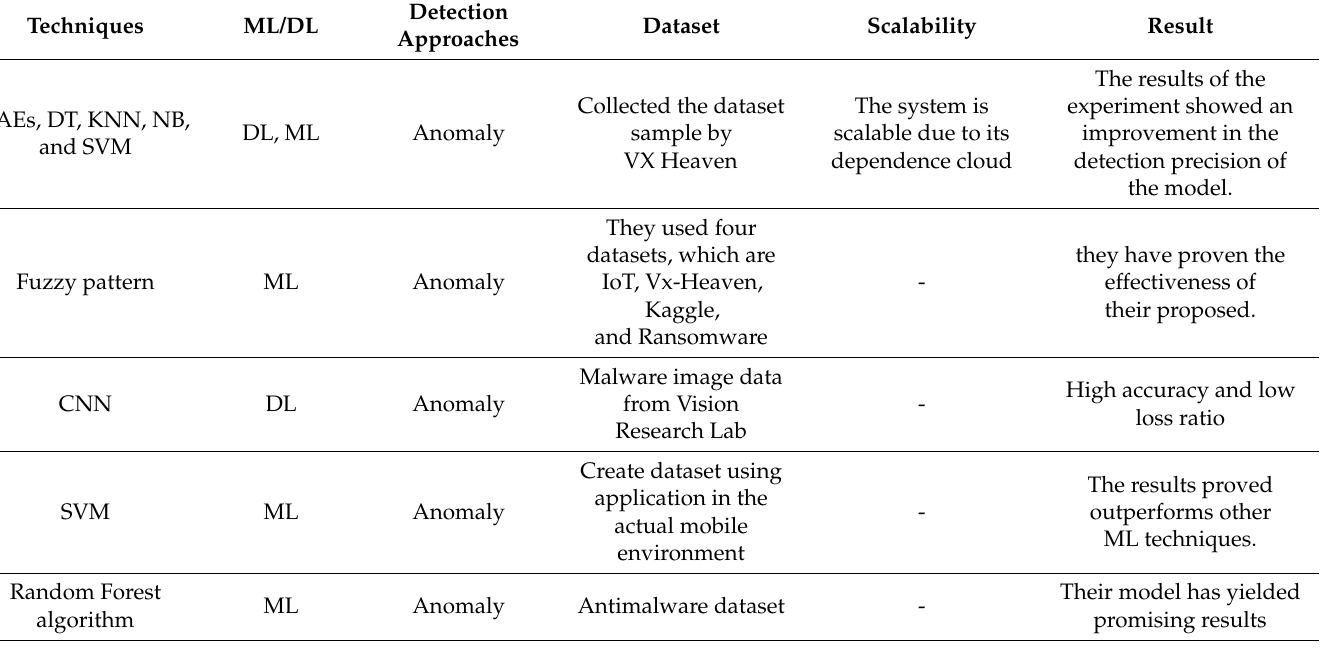
Table 1. Related works